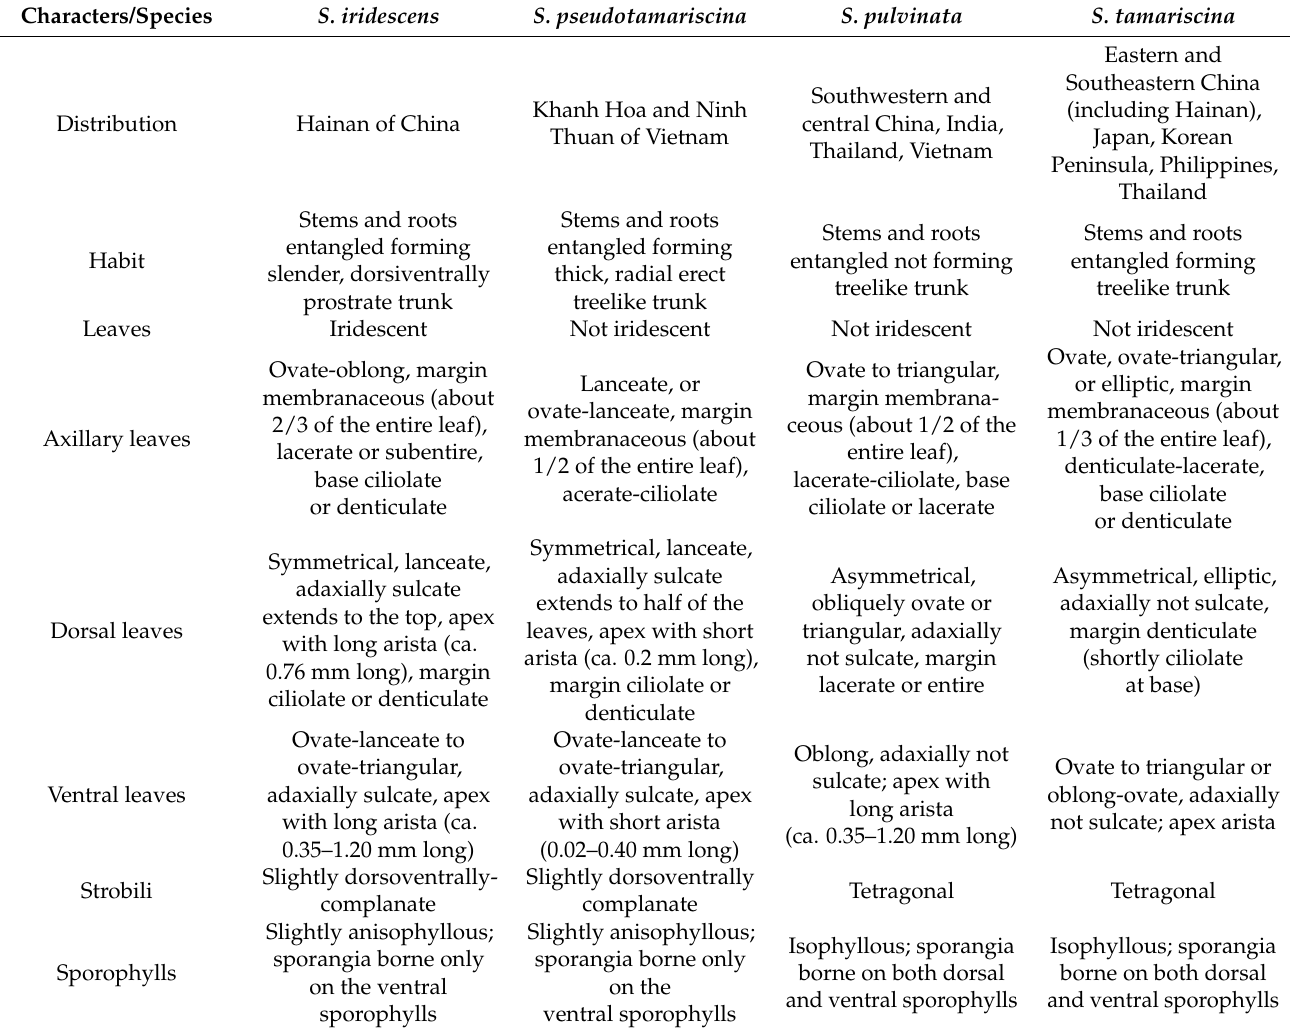
Table 2. Character comparison of S. iridescens , S. pseudotamariscina , S. pulvinata , and S. tamariscina .